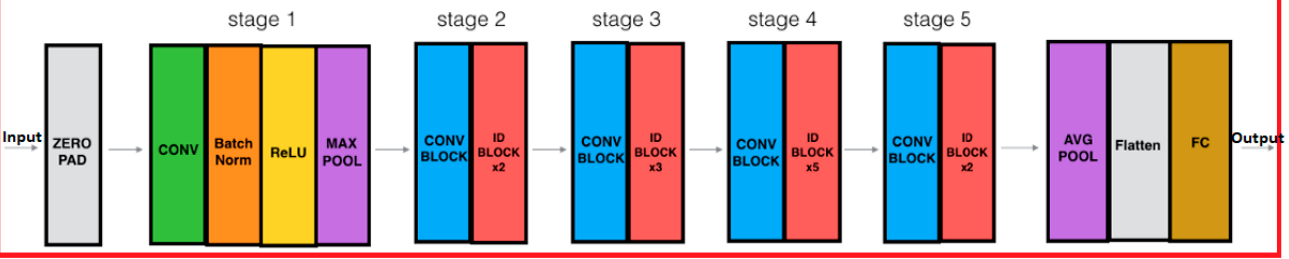
Figure 20. Architecture of Resnet50.